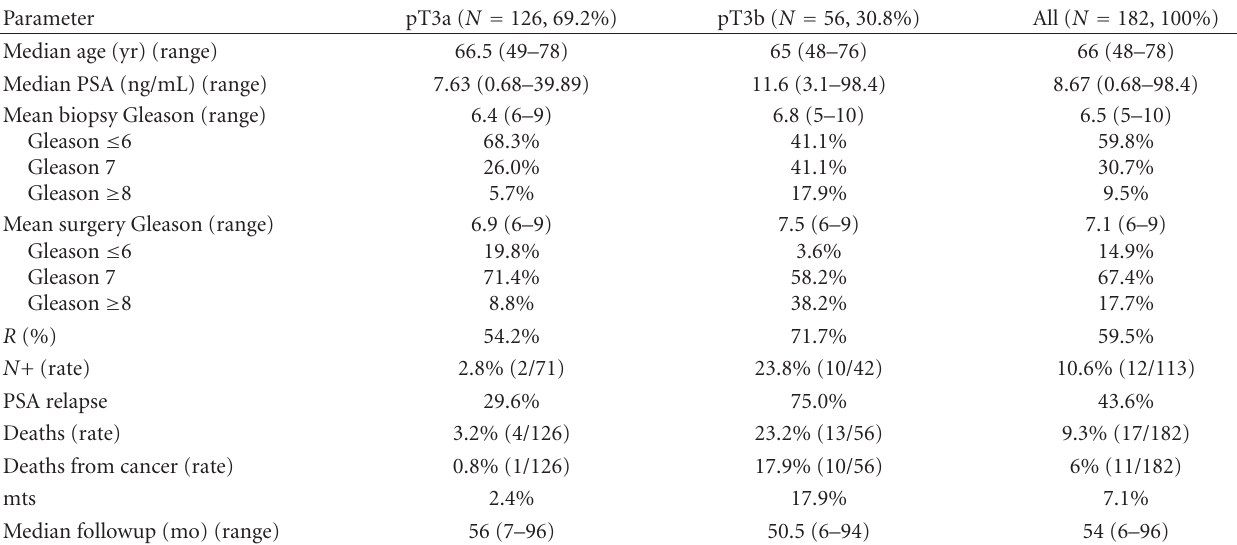
Table 1: Patient characteristics.